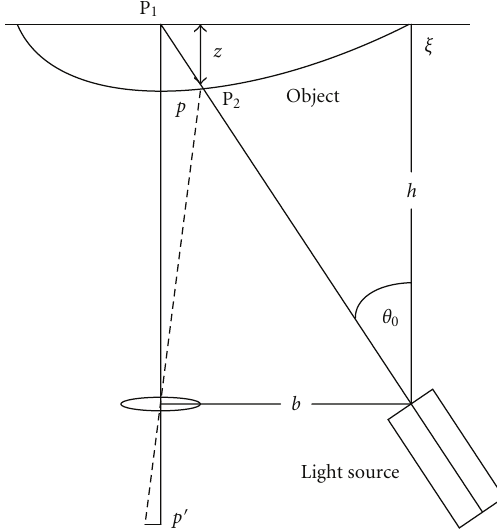
Figure 3: The principle of structured light techniques.